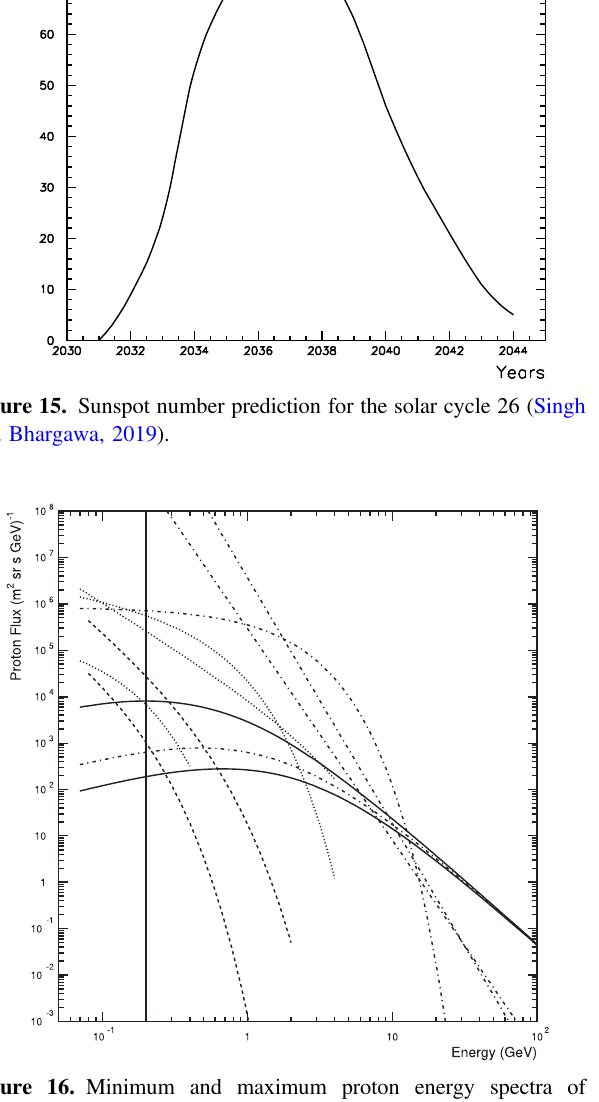
Figure 16. Minimum and maximum proton energy spectra of galactic origin observed near Earth (top and bottom continuous lines, respectively). The bottom dot-dashed line represents the minimum proton fl ux expected during the LISA mission. Dashed lines (December 14, 2006; Adriani et al. (2011)), dotted lines (May 7, 1978; McGuire and von Rosenvinge, 1984) and top dot-dashed lines (February 23, 1956; Vashenyuk et al., 2008) represent solar proton fl uxes observed during the evolution of SEP events of different intensities. The vertical black line indicates the maximum energy of the NGRM proton spectrum measurement capability.